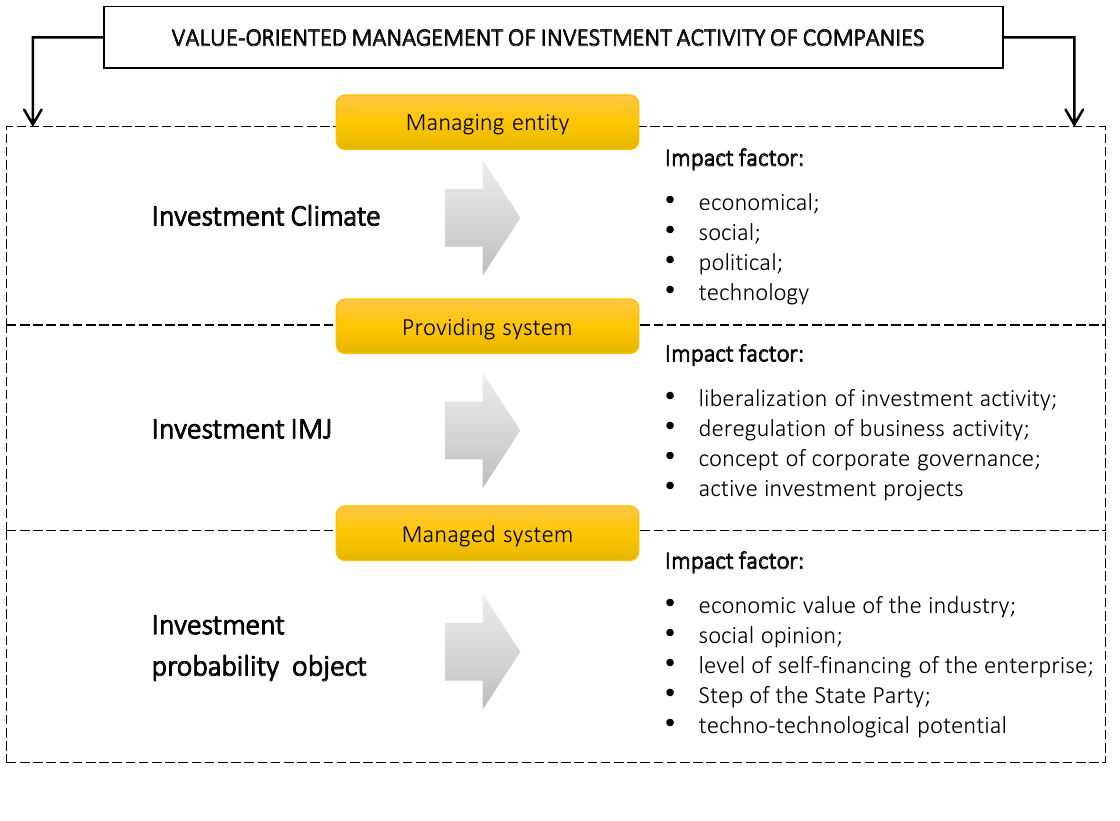
Figure 1. Value-oriented management of investment activity of companies